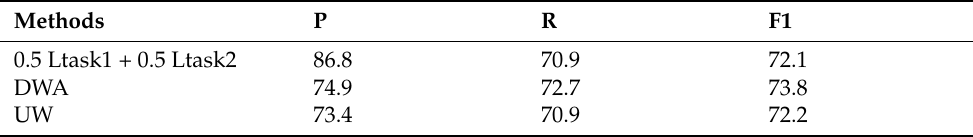
Table 9. Comparison of experimental results of fixed weighting and two kinds of dynamic weighting (%).